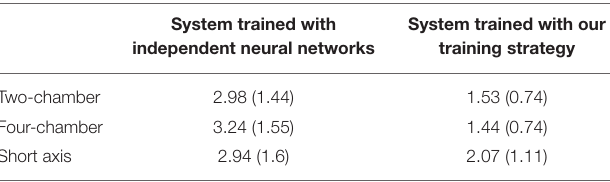
TABLE 2 | Landmark distance errors from neural networks trained independently compared to networks trained with our training strategy. System trained with System trained with our independent neural networks training